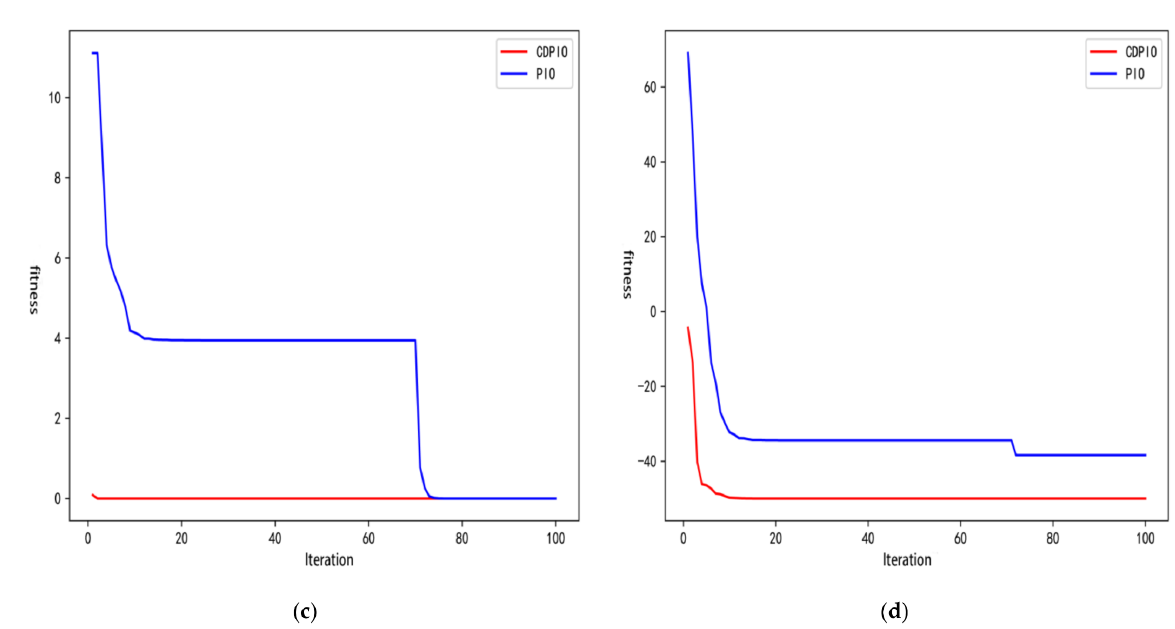
Figure 1. Comparison of convergence curves of 2 algorithms obtained on the benchmark functions. ( a ) is the iterative graph of the low-dimensional unimodal function; ( b ) is the iterative graph of low-dimensional multimodal function; ( c ) is the iter- ative graph of the high-dimensional unimodal function; ( d ) is the iterative graph of high-dimensional multimodal